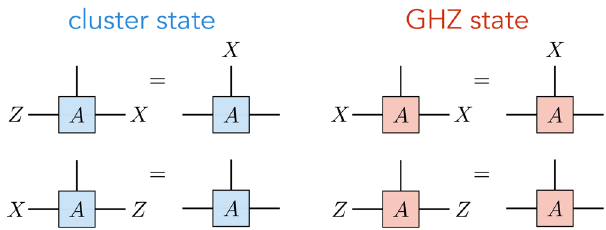
FIG. 9. The symmetries of the 1D cluster and GHZ states. By leveraging these symmetries, Pauli defects appearing on virtual legs, e.g., arising from the fusion of two states via Bell mea- surement, can be “pushed” to the edge of the prepared state by applying appropriate unitaries to the physical